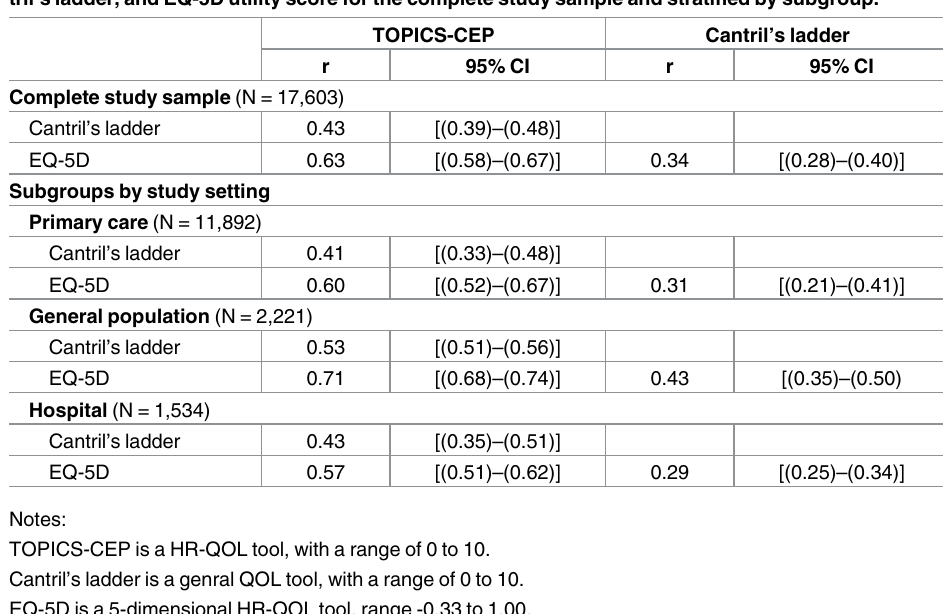
Table 2. Meta-correlation coefficients and the 95% CI of the outcome measuresTOPICS-CEP, Can- tril’s ladder, and EQ-5D utility score for the complete study sample and stratified by